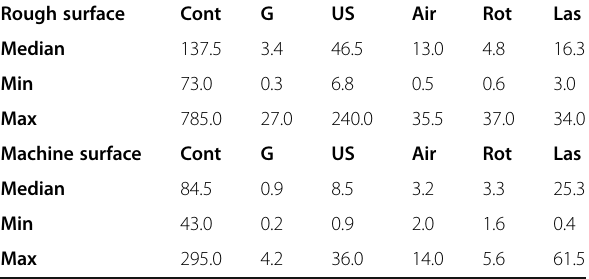
Table 3 Quantitative analysis of CFU counts (× 10 5 ) from rough and machined surface implants after cleansing by each method Rough surface Cont G US Air Rot Las Median 137.5 Min 73.0 Max 785.0 27.0 Machine surface Cont G US Air Rot Median 84.5 Min 43.0 Max